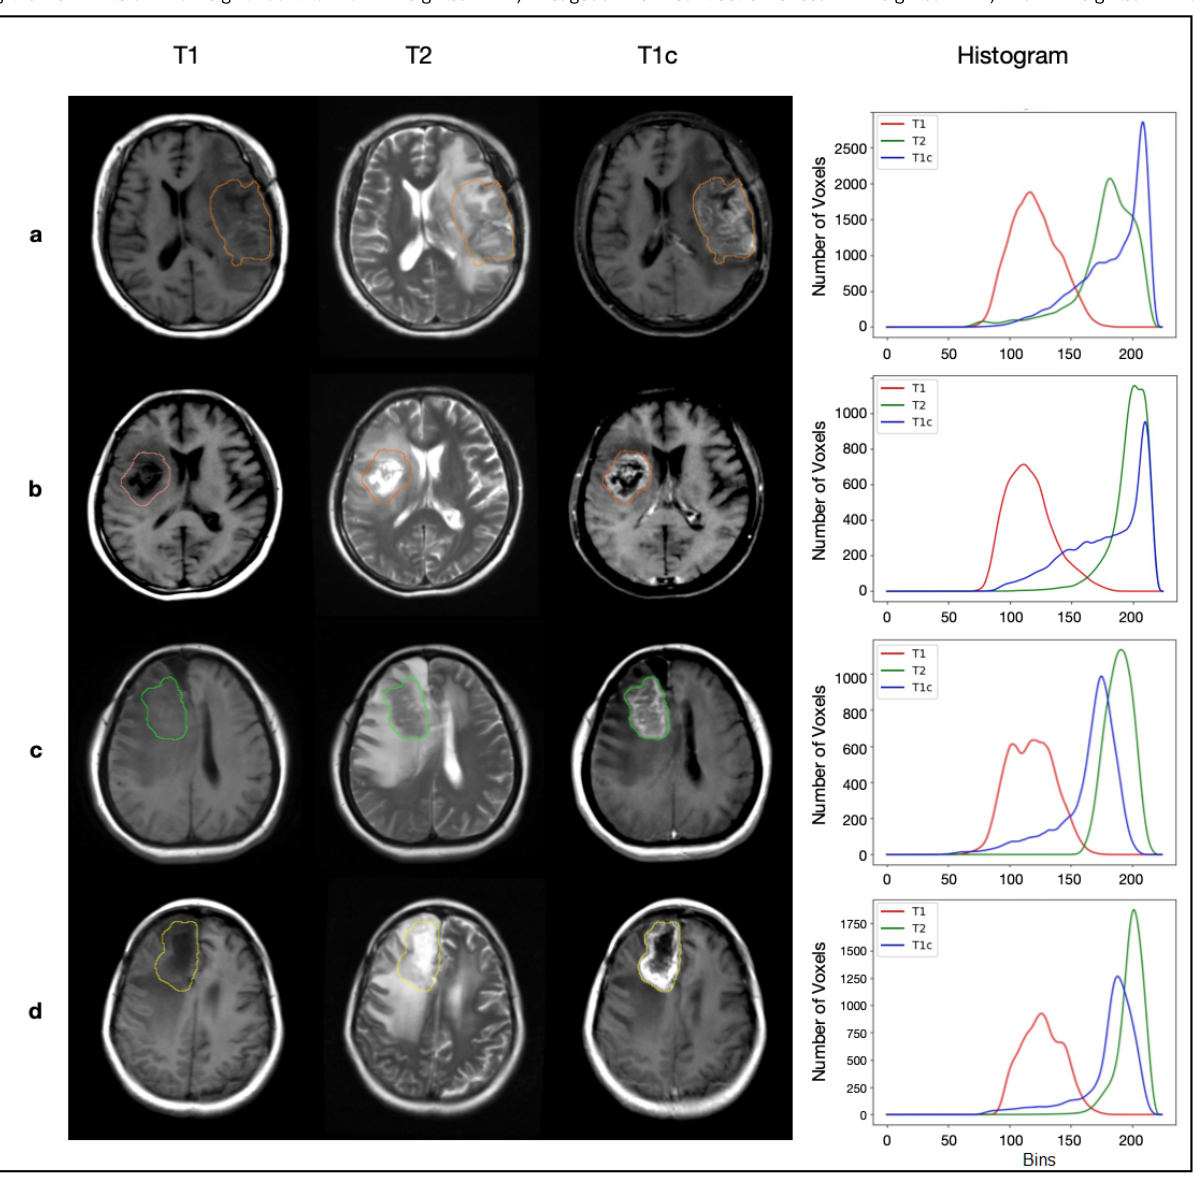
Figure 1. The T1, T2, and T1c magnetic resonance imaging (MRI) sequences of 4 patients with their histograms of the voxels within the lesion masks. Patients (a) and (b) represent recurrent tumors; patients (c) and (d) represent radionecrosis lesions. The lesion masks were manually drawn using the software ITK-SNAP, generally used for delineating regions of interest. The histograms were created for individual sequences and further smoothed using the Hann filter. ITK: Insight Toolkit. T1: T1-weighted MRI; T1c: gadolinium-contrast-enhanced T1-weighted MRI; T2: T2-weighted